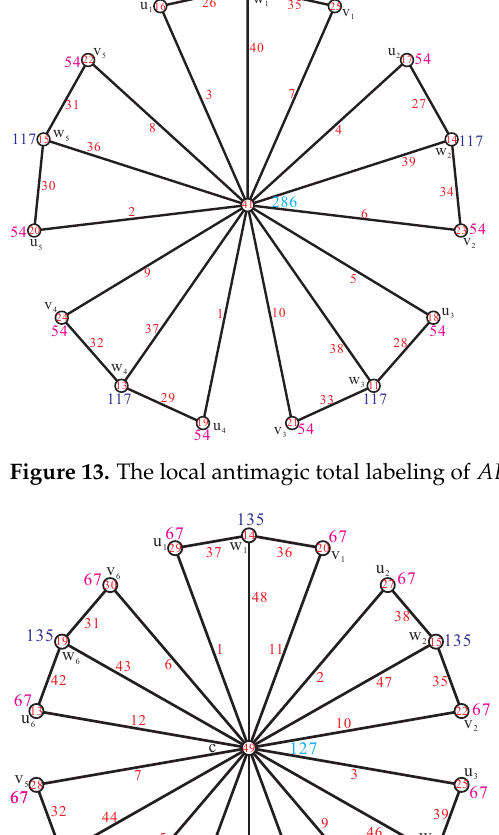
Figure 14. The local antimagic total labeling of AD 6